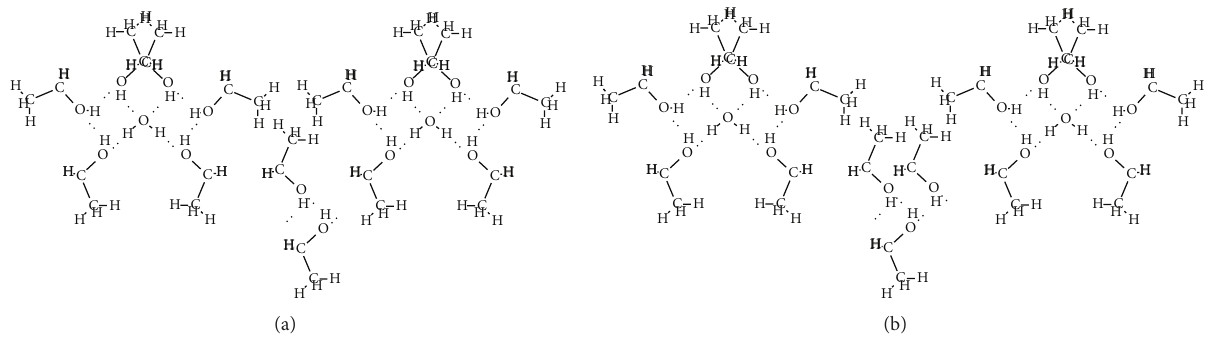
Figure 5: (a) Molecular structure of ethanol of 95.8%v. (b) Molecular structure of ethanol of 96%v.